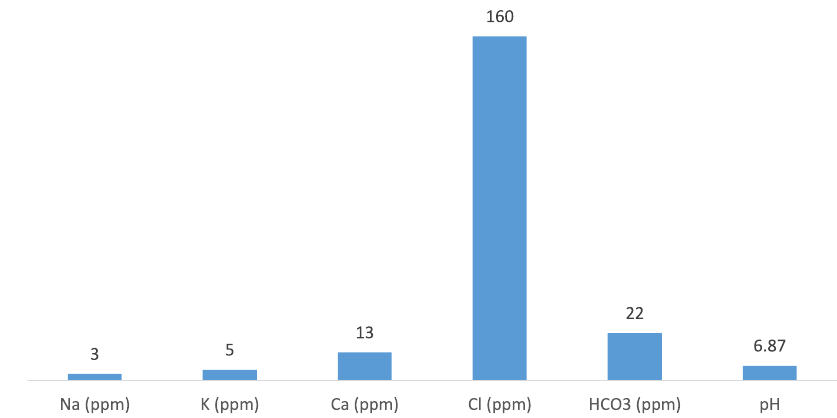
Fig. 2 Intervention (bottled water) compositions. Composition of the fi xed ingredients in each intervention (bottled